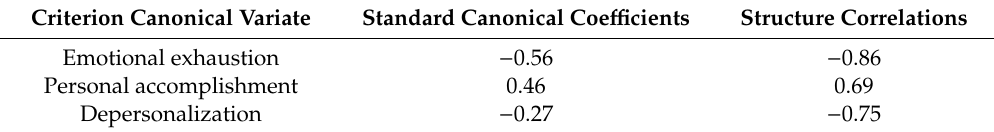
Table 2. Standardized canonical coefficients and structure correlations of the first criterion canonical